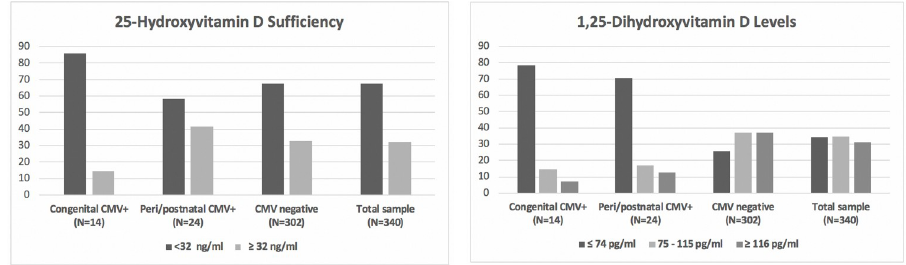
based on tertiles, compared by CMV transmission status.